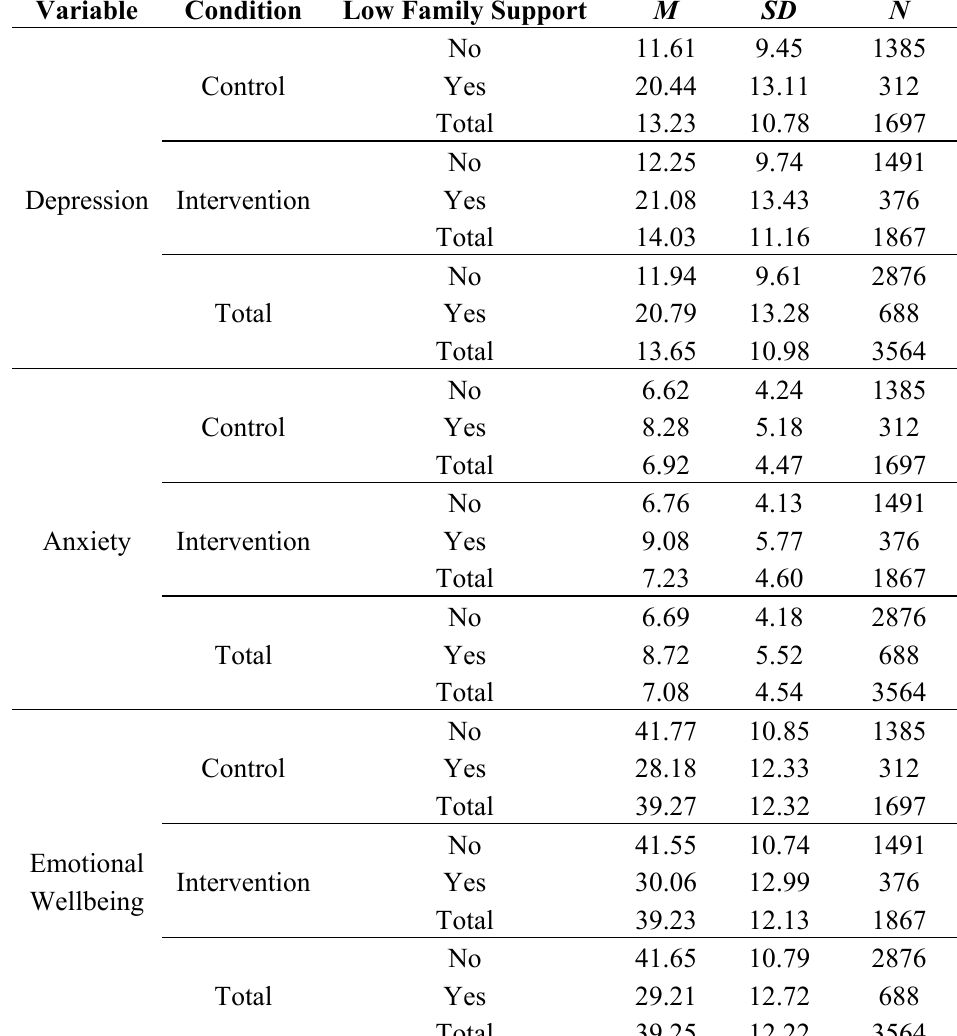
Table 1. Baseline characteristics by family support status by condition for outcome measures for those available at